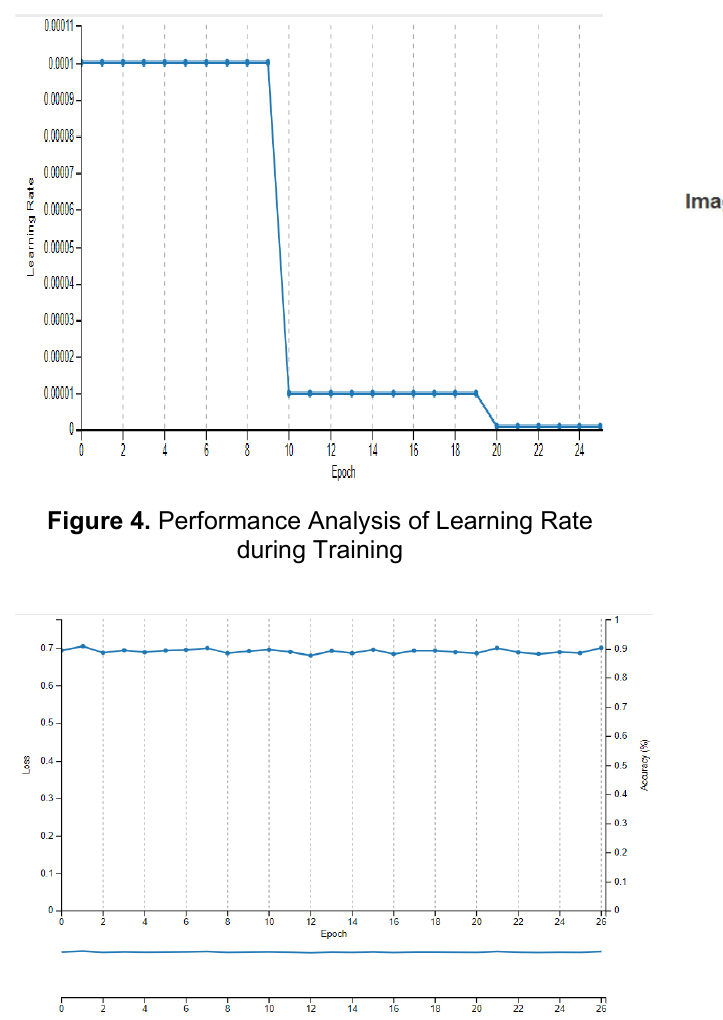
Figure 8. Predicted Image of